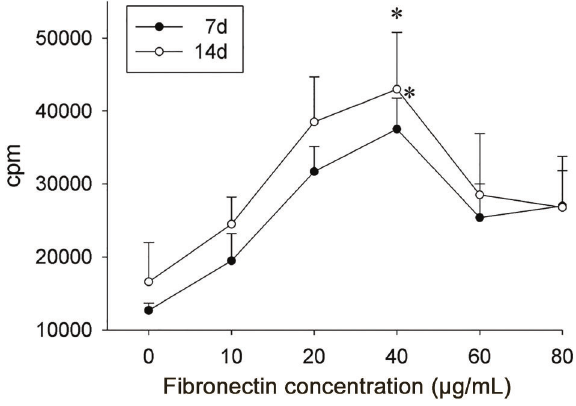
Figure 8. 3 H-proline incorporation test showing that fi bronectin up-regulated the collagen synthesis of fi broblasts. Collagen synthe- sis in the 40 m g/mL fi bronectin group was signi fi cantly higher at 7 and 14 days than the other groups (*P o 0.05, ANOVA). Data are reported as means ± SD. cpm: counts per minute.